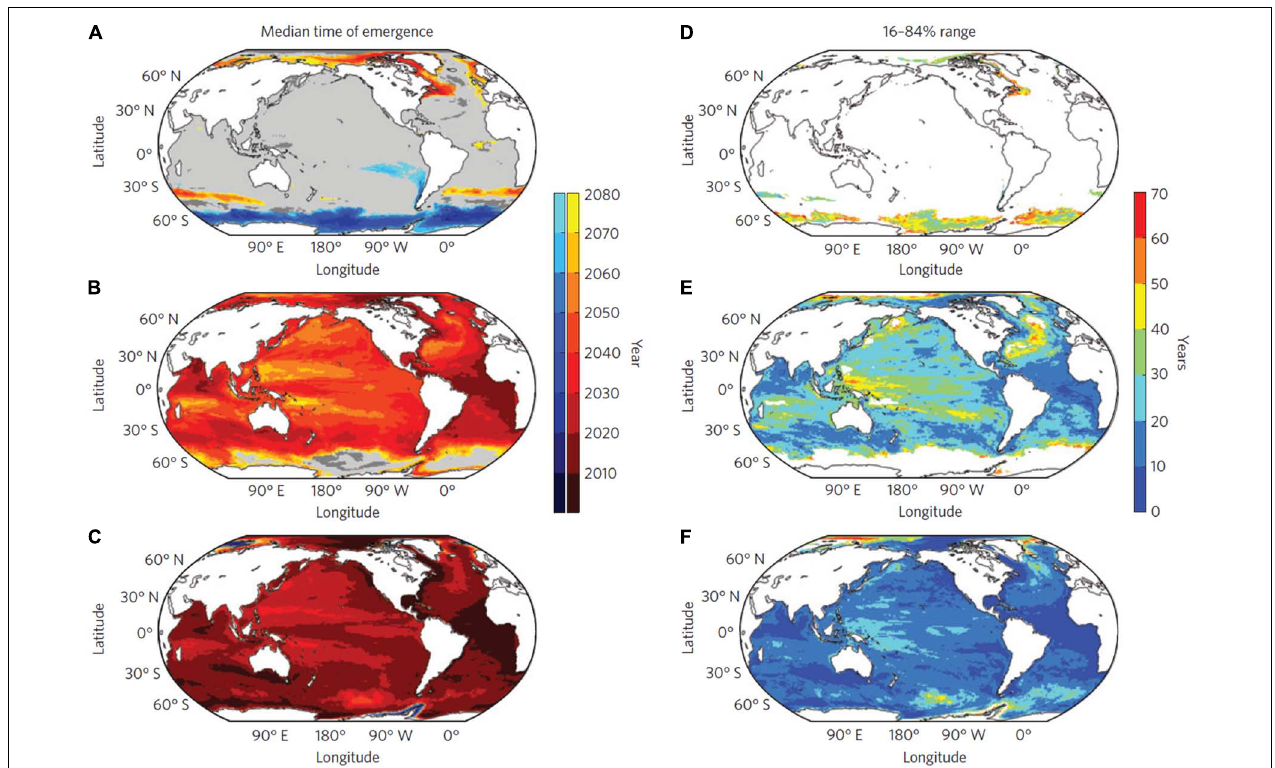
FIGURE 7 | Time after which changes in local sea level are always larger than modeled local sea level variability (ensemble median) under RCP8.5, by year, for: (A) dynamic sea level, (B) dynamic plus global thermosteric sea level, and (C) all contributing components to regional sea level. Gray color means that no signal has yet emerged by 2080 or no agreement between models. The 16–84% uncertainty ranges at regions where at least 84% of the models in the ensemble show signal emergence by 2080 are shown in the right panels (D–F) for the same sea level change projection estimates (A–C) . Adapted with permission from Figure 2 of Lyu et al.